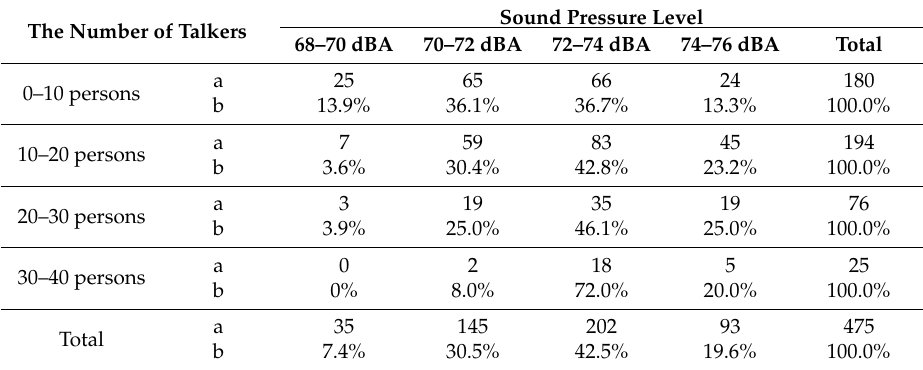
Table 6. The cross-tabulation of the number of talkers and sound pressure